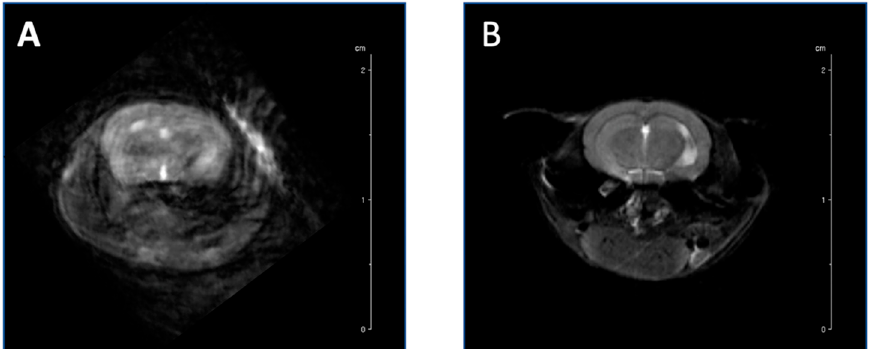
Figure 5. Highly motion-sensitive T 2 -weighted axial images of the brains of two mice show the significant reduction of motion and artifacts during the awake MRI imaging process. Anatomical image acquired with previously designed mouse holder ( A ) vs our newly designed mouse holder ( B